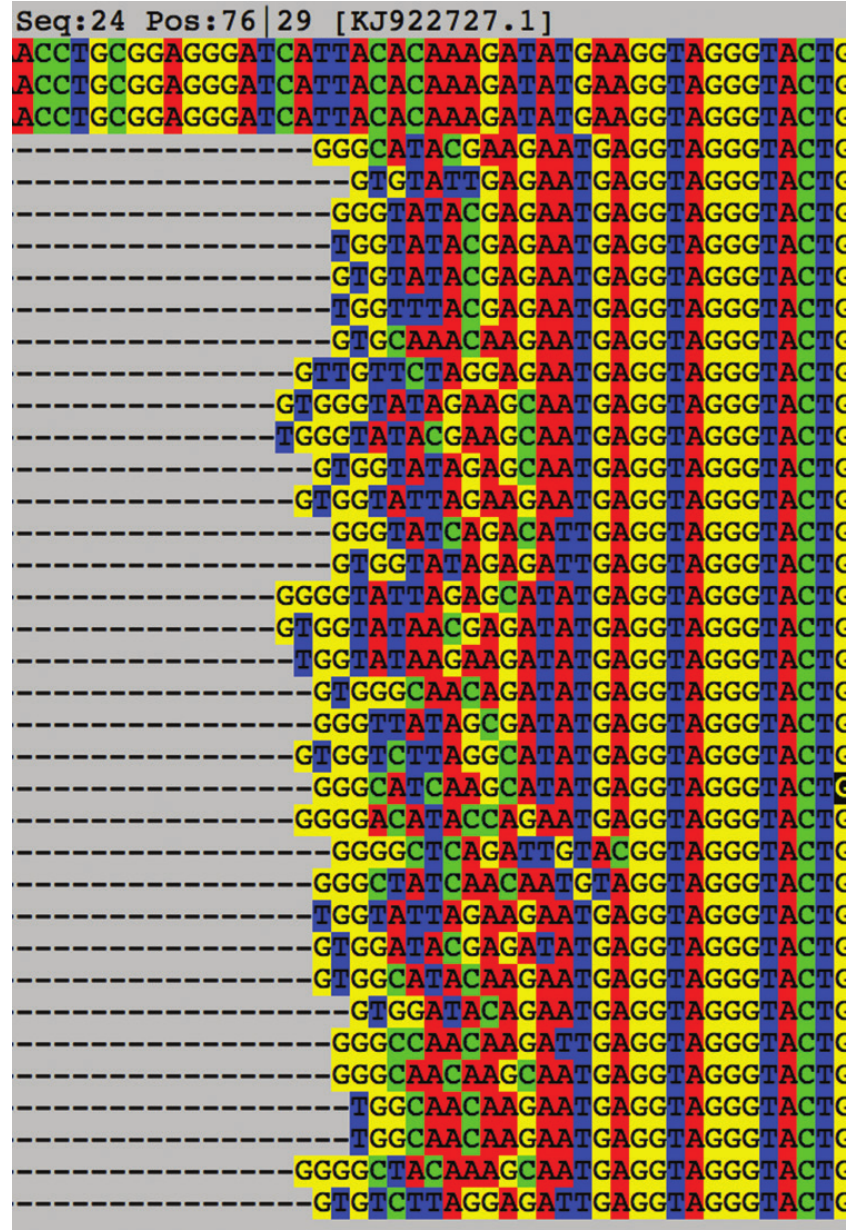
Figure 1. Example of poorly trimmed sequences (sequence four and on) from the species Setosphaeria turcica . The 5’ end of the alignment is shown, and the poorly trimmed sequences cover the last ~5 bases of SSU and the immediate start of ITS1. The topmost sequence is genome-derived, and sequences two and three are regular Sanger sequences retrieved from the INSDC from other studies than the one with the poorly trimmed sequences (sequences four and on). SeaView v. 4 (Gouy et al. 2010) was used to visualize the